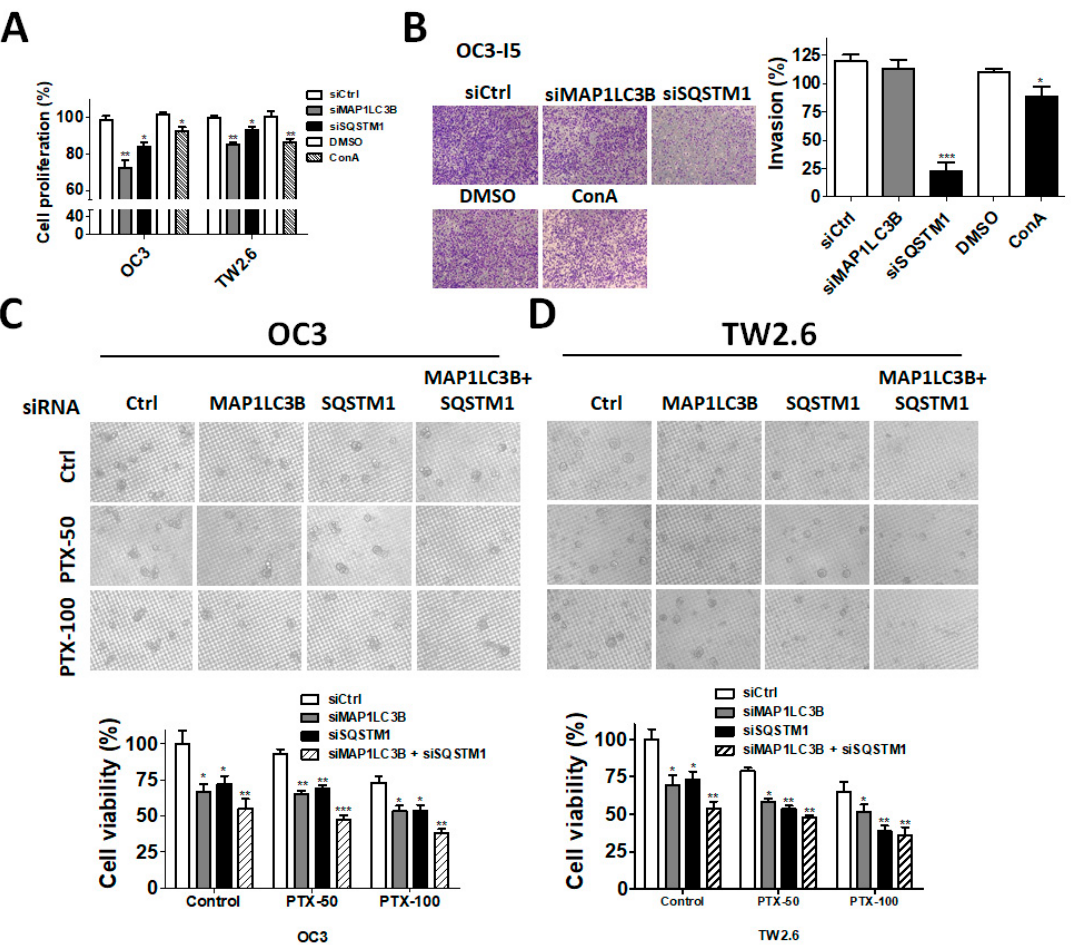
Figure 7. Effects of silencing MAP1LC3B and SQSTM1 on metastatic characteristics, tumorsphere formation and paclitaxel sensitivity in BMSCC cells. ( A ) The BMSCC cell lines OC3 and TW2.6 were transfected with 5 nM scrambled siRNA or siRNA against MAP1LC3B or SQSTM1 for 72 h to measure cell proliferation with Cell titer Glo. The cells treated with the autophagy inhibitor ConA for 24 h were used as a control. ( B ) OC3-I5 cells, the highly invasive strain of OC3, were silenced for 48 h and were seeded in Matrigel-coated Transwell filters to assess the cell invasion of BMSCC cells. ( C ) The silenced OC3 and ( D ) TW2.6 cells were cultured in nanoplates to examine tumorsphere formation. The tumorspheres were also treated with or without paclitaxel (PTX, 50 or 100 nM) to determine the effects